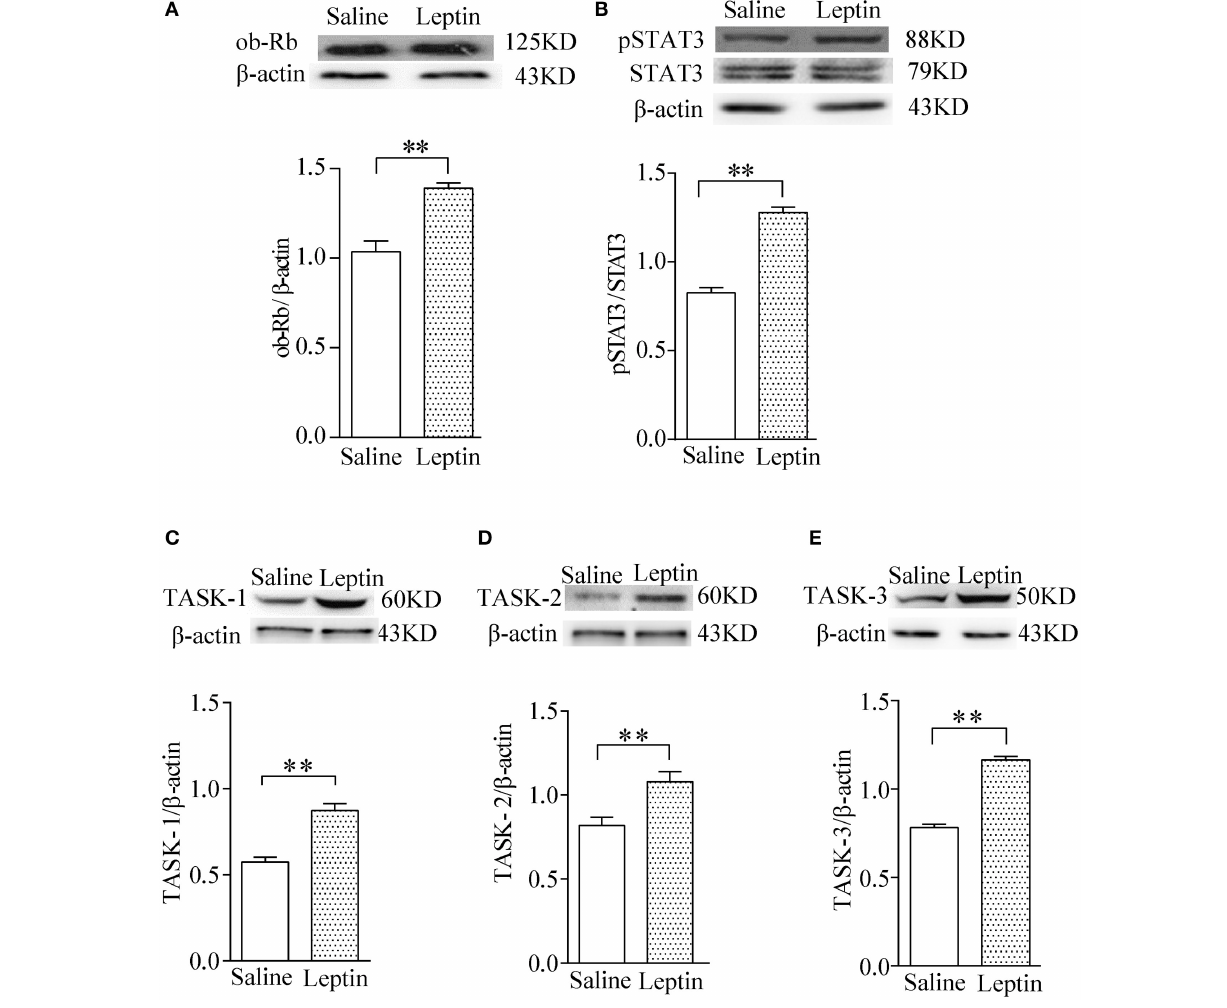
FIGURE 4 | Stimulatory effect of leptin on pSTAT3/STAT3 and TASK-1,-2,-3 channel protein expression in CBs. Gel images and bar charts showing quantitative analysis of leptin-stimulated expression of ob-Rb (A) pSTAT3/STAT3 (B) and TASK-1,-2,-3 (C–E) in the CB ( n = 8) of each group ( n = 4). ** P < 0.01 by two-tailed unpaired t